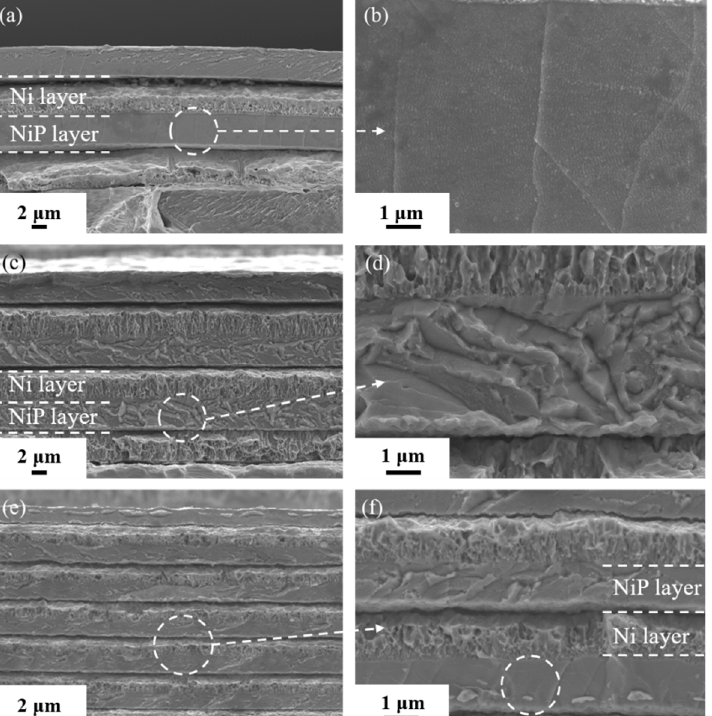
Figure 5. SEM images of tensile fracture surfaces of specimens with different coating thickness: ( a ) Specimen with 7.5 μ m NiP/7.5 μ m Ni composite coating; ( b ) Enlarged view of the white circle in ( a ); ( c ) Specimen with 5 μ m NiP/5 μ m Ni composite coating; ( d ) Enlarged view of the white circle in ( c ); ( e ) Specimen with 2.5 μ m NiP/2.5 μ m Ni composite coating; ( f ) Enlarged view of white circle in ( e ).